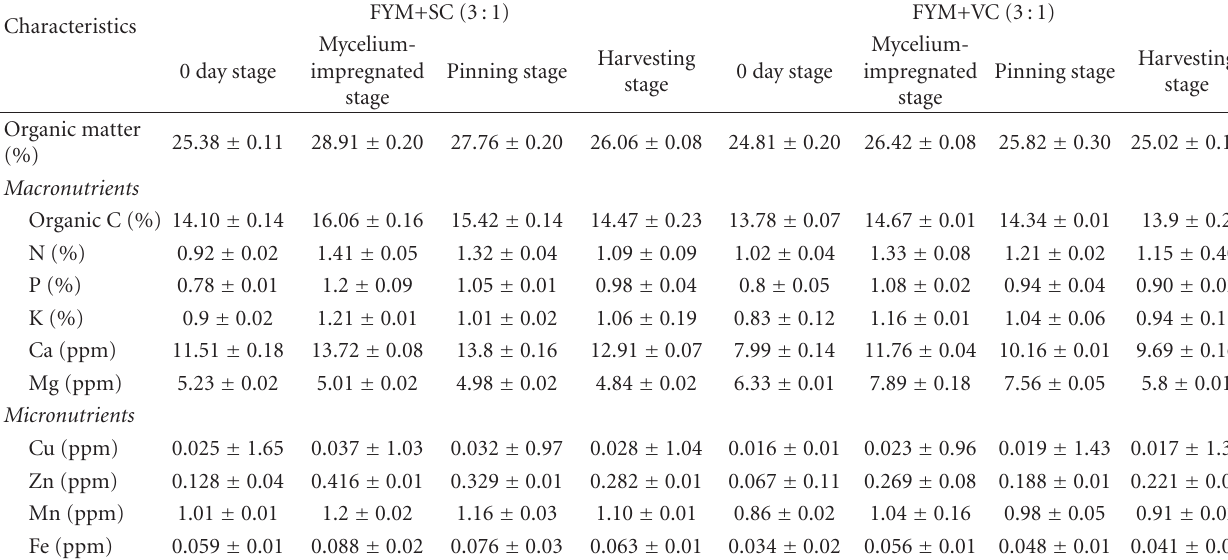
Table 2: Chemical characteristics with respect to macro- and micronutrients for casing mixtures recovered during the successive stages of button